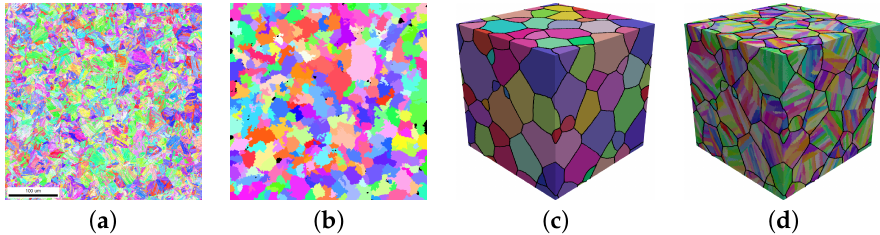
Figure 5. Inverse Pole Figure (IPF) maps, color legend is given in Figure 2a: ( a ) Raw experimental microstructure (includes retained austenite). ( b ) Prior austenitic microstructure. Black color means no indexing was possible. ( c ) Synthetic austenitic microstructure in 3D. ( d ) Martensitic microstructure. Black lines in ( c , d ) represents austenite grain